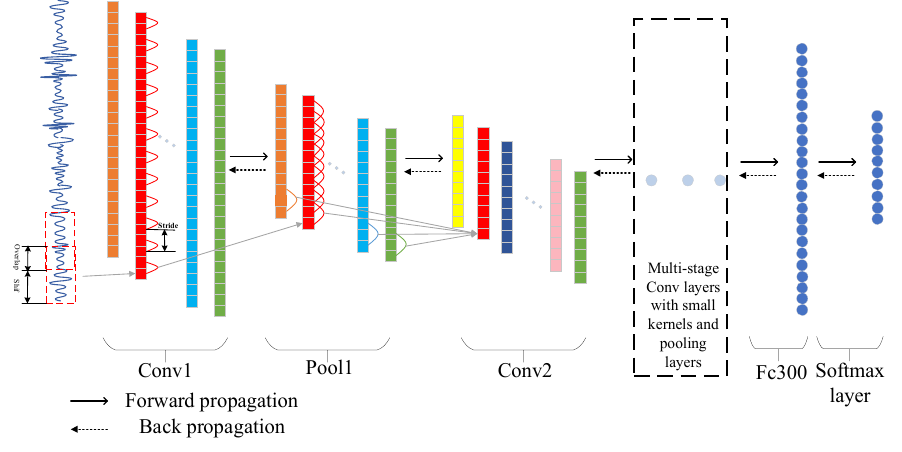
Figure 2. Structure of the proposed 1DCNN model.